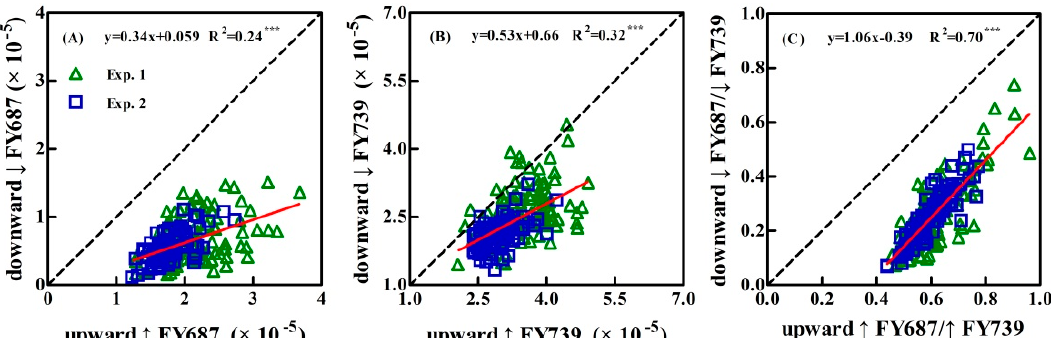
Figure 12. Linear relationship between upward and downward SIF yield indices: A (upward ↑ FY687, downward ↓ FY687), B (upward ↑ FY739, downward ↓ FY739) and C (upward ↑ FY687/ ↑ FY739, downward ↓ FY687/ ↓ FY739) for two datasets of Experiment 1 and Experiment 2 shown in green (triangle) and blue (square), respectively. Statistical significance is shown as * p < 0.05; ** p < 0.01; *** p < 0.001.